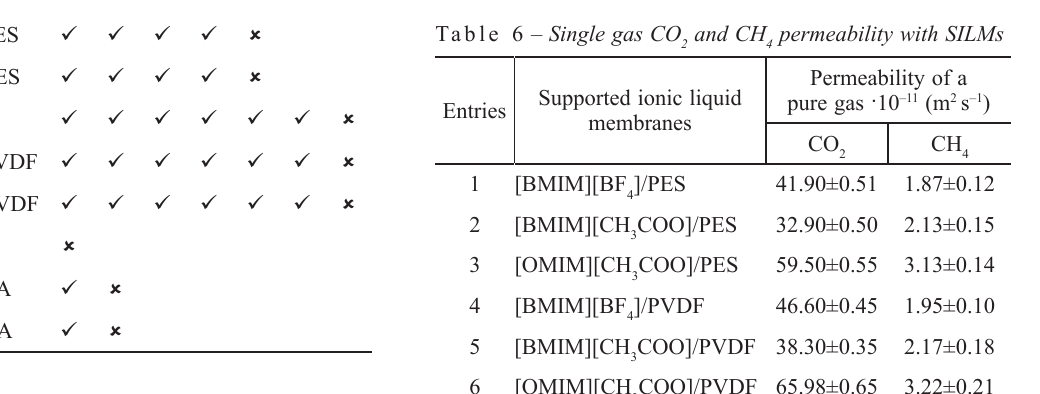
Table 6 – Single gas CO